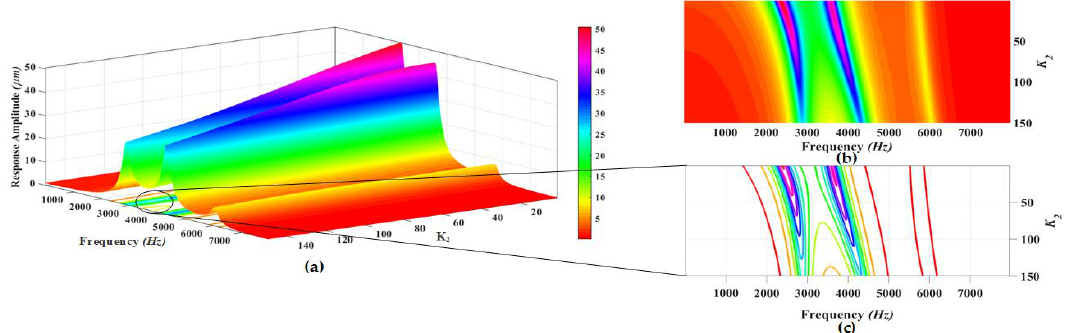
Figure 11. ( a ) Response amplitude and bandwidth optimization graph for the variation of k 2 ; ( b ) Top view and ( c ) Contour plots of the system response.